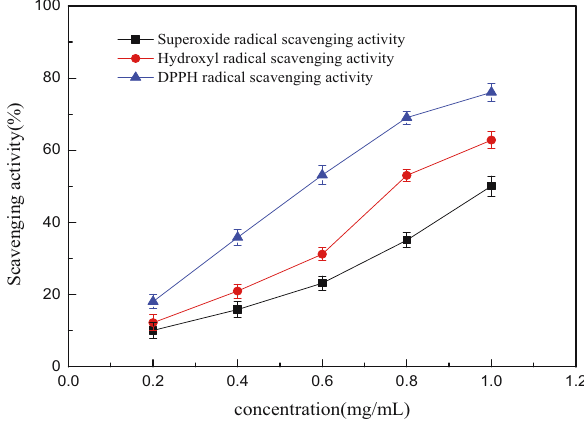
Figure 10: Comparison of scavenging e ff ects of nano - selenium on − , ˙ DPPH, and ˙ ˙ O 2